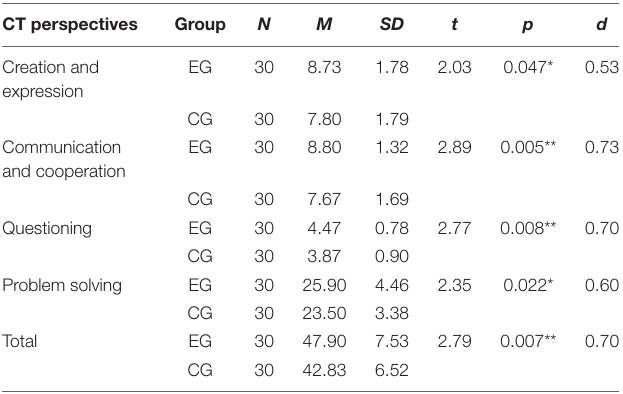
TABLE 12 | The independent sample t -test of the two groups’ CT perspectives post-test. CT perspectives